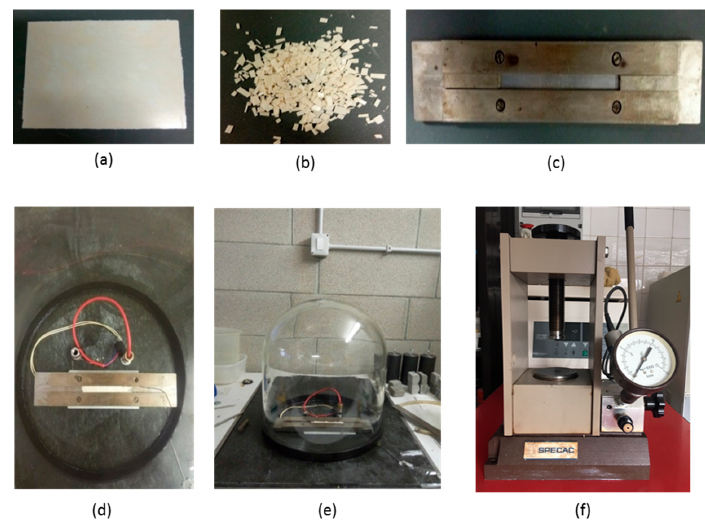
Figure 1. Experimental procedure for mechanical recycling: Raw ( a ) and cut ( b ) material; mold ( c ); resistance ( d ); vacumm ( e ); hydraulic press ( f ).